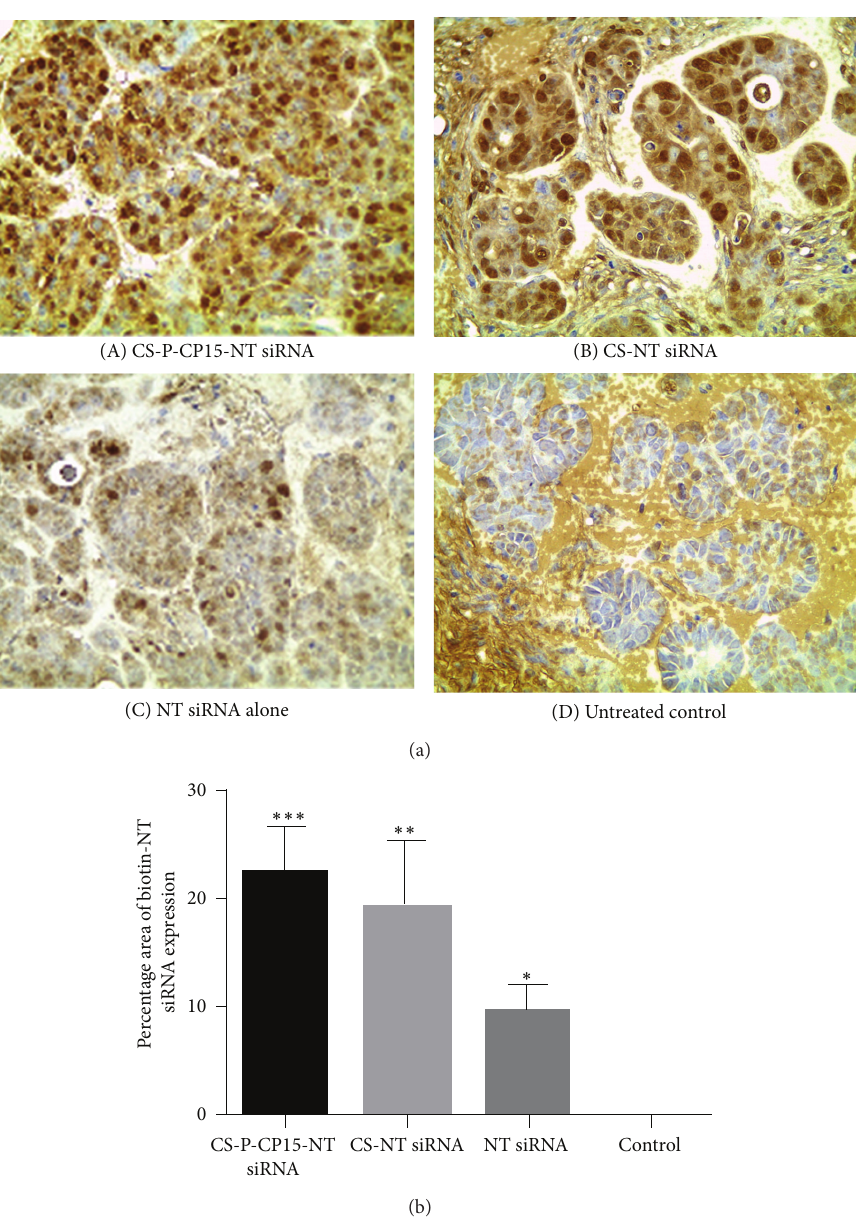
Figure 3: Analysis of nanoparticles accumulation in the tumor tissue after 4 h of dose administration. (a) Histopathological images of SW480 colon cancer tissue stained dark brown in color, indicating the presence of scrambled biotinylated siRNA (0.5 mg/kg) in the tumor tissue after intraperitoneal administration of the treatment nanoparticle formulation. Animals were sacrificed after 4hrs. (A) Chitosan-PEG-CP15 (B) Unmodified chitosan nanoparticles (C) non-targeting biotin siRNA alone, (D) control: untreated. (b) Image analysis of the mean percent area stained in the tumor tissues. The graph shows a representative result of the average of three random sections measured per animal tissue, mean ± SD. ∗ 𝑃 < 0.05 , ∗∗ 𝑃 < 0.01